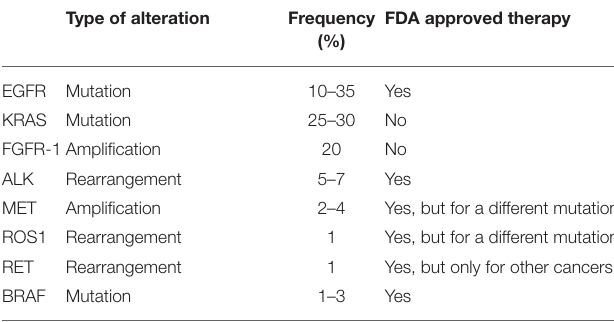
FIGURE 1 | Common driver mutations in lung cancer. Lung cancers have historically been subdivided into either small cell lung cancer (SCLC), or non-small cell lung cancer (NSCLC). Small cell lung cancer has few oncogenic driver mutations; here are listed the most frequently identified genetic mutations in SCLC (Left) . NSCLC can further be subdivided into squamous cell lung carcinoma (SCC), or lung adenocarcinoma (LUAD). Multiple oncogenic drivers have been identified in LUAD (Right) ; for many of these targeted therapies have been developed. For SCC (Middle) , there are fewer identified oncogenic drivers, and no targeted therapies have been approved. TABLE 1 | Genomic alterations of lung